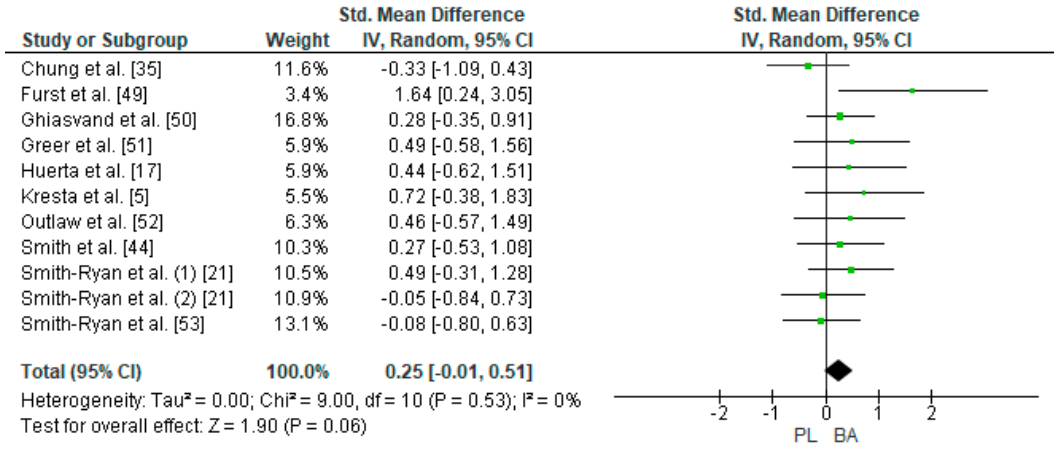
Figure 6. Forest plot comparing the effect of BA on Limited Time Test. BA: beta ‐ alanine; PL: placebo.